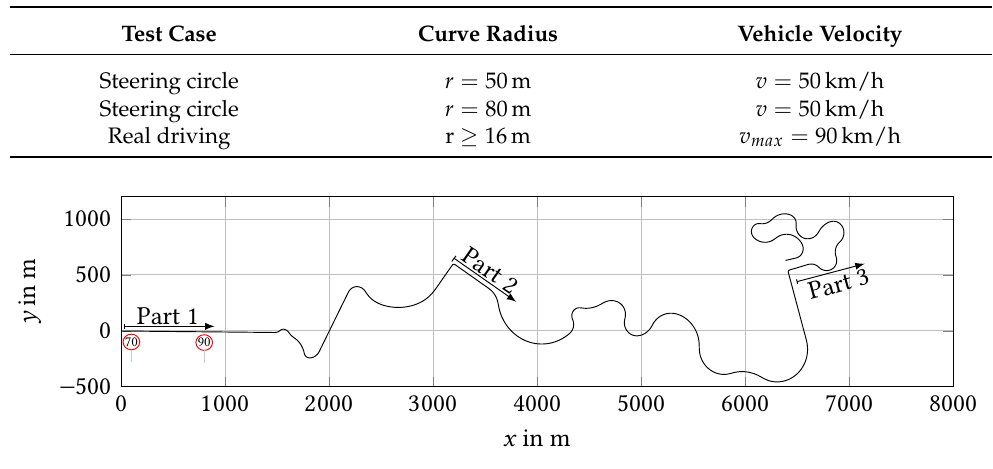
Figure 7. Virtual real driving